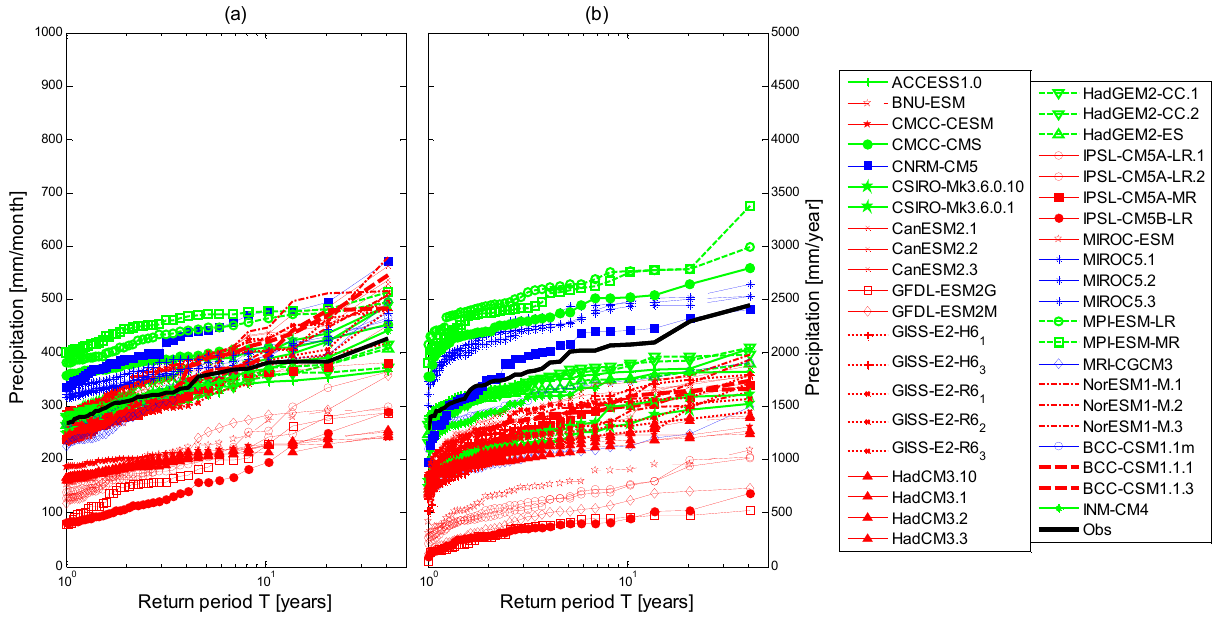
Figure 8. ( a ) Return period of average monthly precipitation; ( b ) Average annual precipitation for the different GCM simulations as compared to the observed series; red: LR GCMs; blue: HR GCMs; green: MR GCMs.